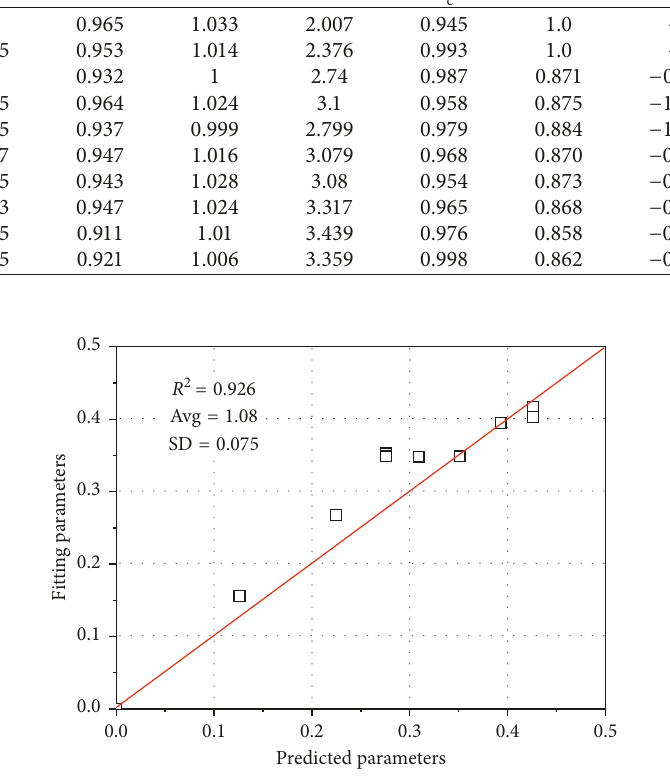
Table 4: Fitting results of damage evolution laws of HFRC under cyclic compression and tension. Specimen